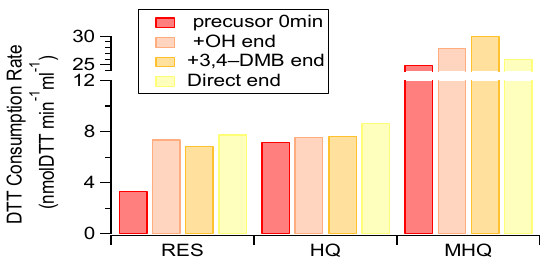
Figure 7. Dithiothreitol (DTT) consumption rates of aqueous-phase oxidation products and the corresponding pure precursors. The 0 min samples represent solutions containing only 100 µ M precursor with no oxidants, while the end samples were taken at the end of the experiments (about half precursor was consumed).